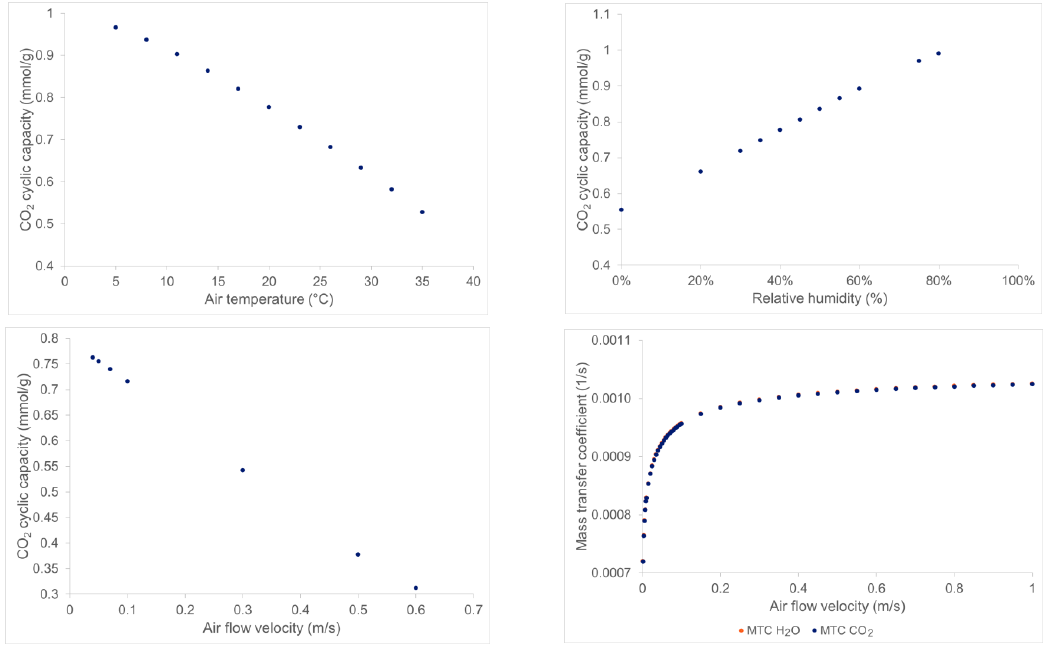
Figure 5. Results of the different parametric studies on the CO 2 cyclic capacity of the process at the lab-scale. Figure 5 (bottom-left and right) shows the evolution of the CO 2 cyclic capacity and